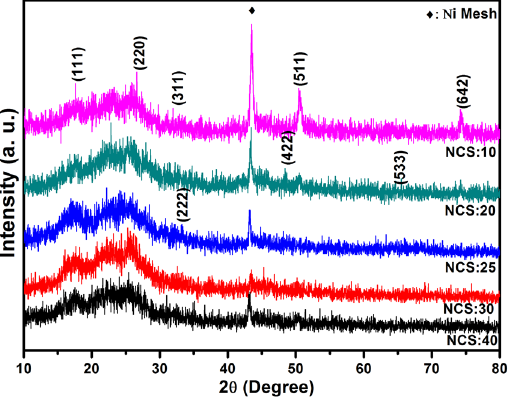
Figure 1. XRD patterns for the NiCo 2 S 4 thin films prepared with various molar ratios of Ni to Co precursor using SILAR